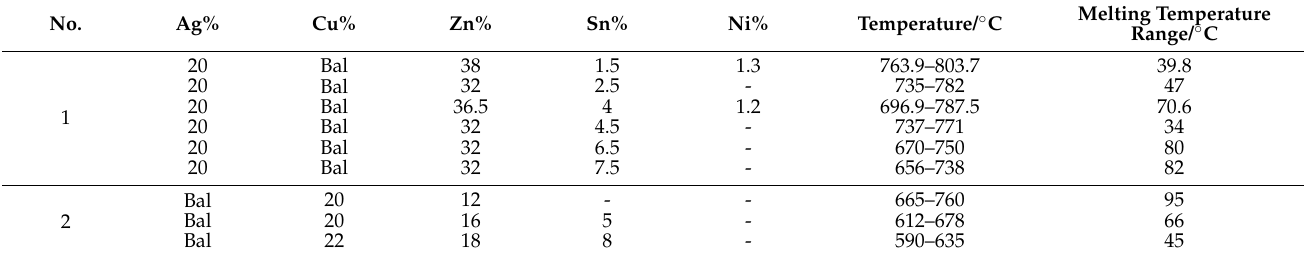
Table 2. Melting characteristics of some Ag-Cu-Zn series brazing filler metals with different contents of Sn [21–23]. No. Ag%